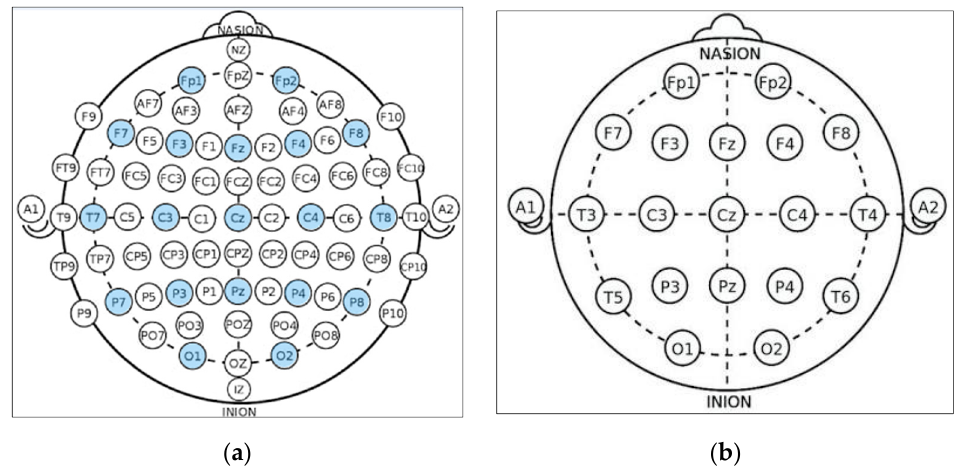
Figure 2. Schematic presentation of EEG electrode positions for: ( a ) CHB-MIT electrode positions where the adopted electrodes are highlighted with the blue color; ( b ) KAU electrode positions.